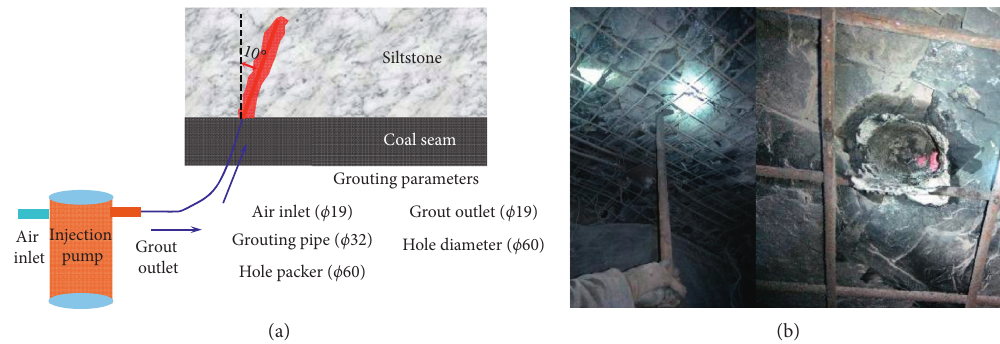
Figure 14: Grouting construction process of No. 21209 working face: (a) on-site grouting process, (b) grouting construction, and (c) hole sealing completed.